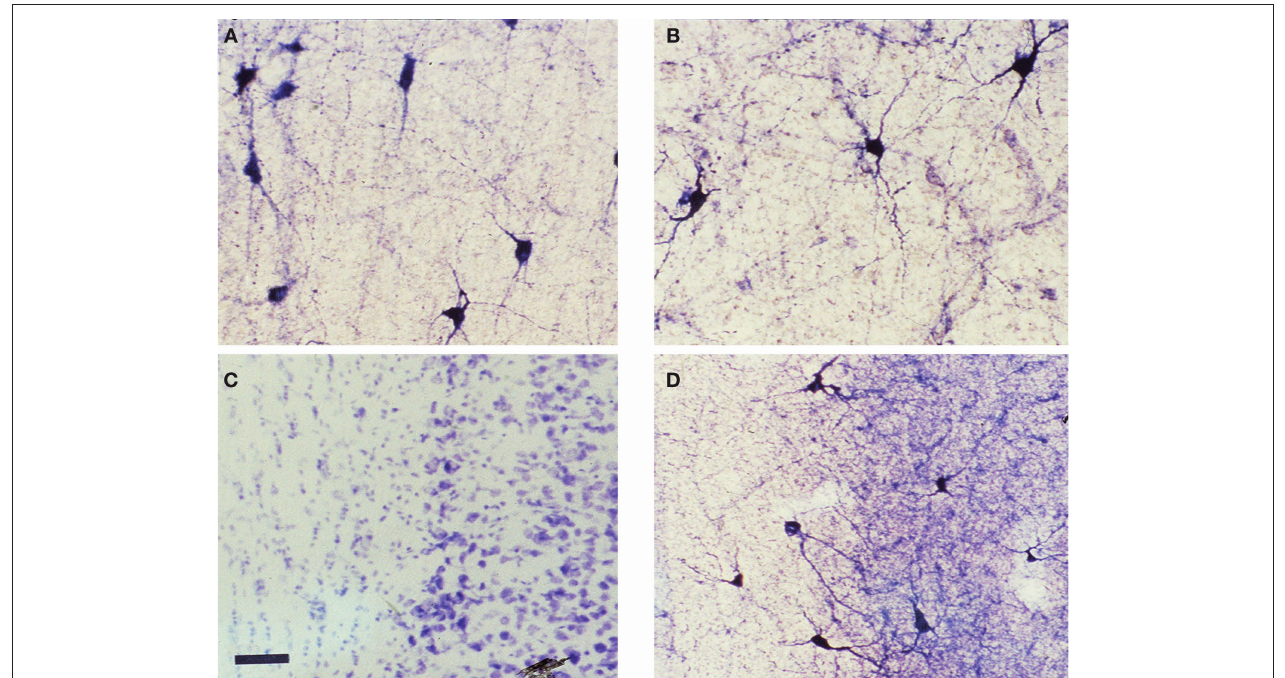
NADPHd positive in the white matter and considerable staining of processes, as well. The rat tissue sections illustrate a standard Nissl stain (C) where the subplate neurons can be visualized as a compressed layer at the bottom of layer 6 and the white matter is seen below. The section in (D) (an adjacent section) has been processed for NADPHd histochemistry – several NADPHd positive neurons can be seen in the white matter and in the subplate subgriseal area at the bottom of layer 6. Scale bar = 50 µm and applies to all four panels.